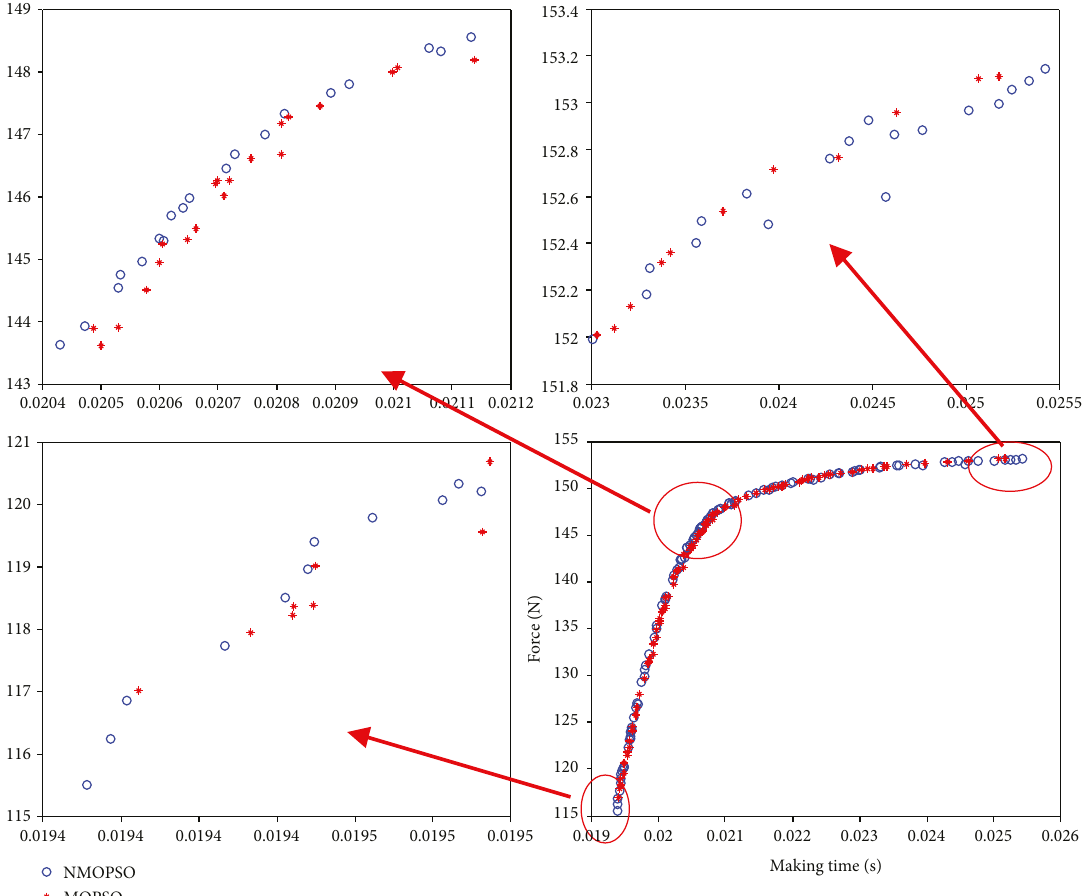
Figure 4: The Pareto front of the force and making